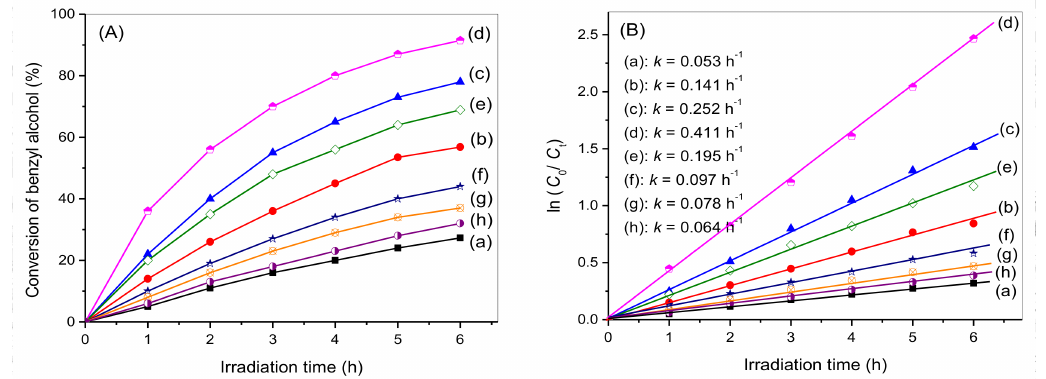
Figure 8. ( A ) Time involved photocatalytic conversion of benzyl alcohol over as-synthesized HTT/graphene nanocomposites: (a) pure HTT, (b) HTT/graphene-0.2%, (c) HTT/graphene-0.4%, (d) HTT/graphene-1.0%, (e) HTT/graphene-2.0%, (f) HTT/graphene -4.0%, (g) P25 TiO 2 /graphene-1.0%, and (h) HTT/graphene-1.0%-mixed; ( B ) The corresponding first-order kinetics plots over these photocatalysts.